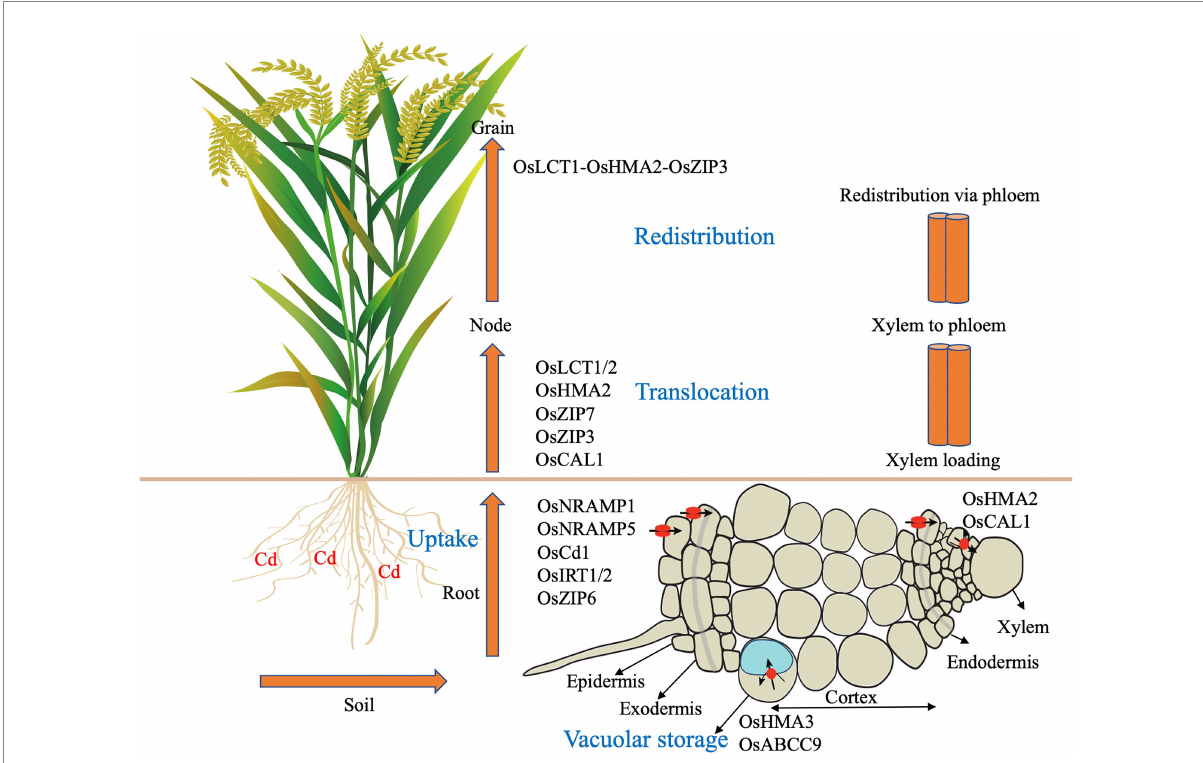
FIGURE 1 Summary of the contribution of genes function in Cd homeostasis. Cd accumulation in plants is first through root absorption, storage in root vacuoles, xylem loading, xylem to phloem transfer and redistribution. Cd is uptake by rice root in soil. OsNramp1, OsNramp5, OsCd1, and OsITR1/2 are suggested to mediate this process. OsHMA3 and OsABCB9 are response for Cd sequestration into vacuoles in root. OsHMA2 and OsCAL1 contributes to the loading process of Cd into xylem in root. OsLCT1/2, OsHMA2, OsZIP3/7 and OsCAL1 are responsible for intervascular Cd transfer at nodes. Co-expression of OsLCT1-OsHMA2-OsZIP3 could reduce the redistribution of Cd in